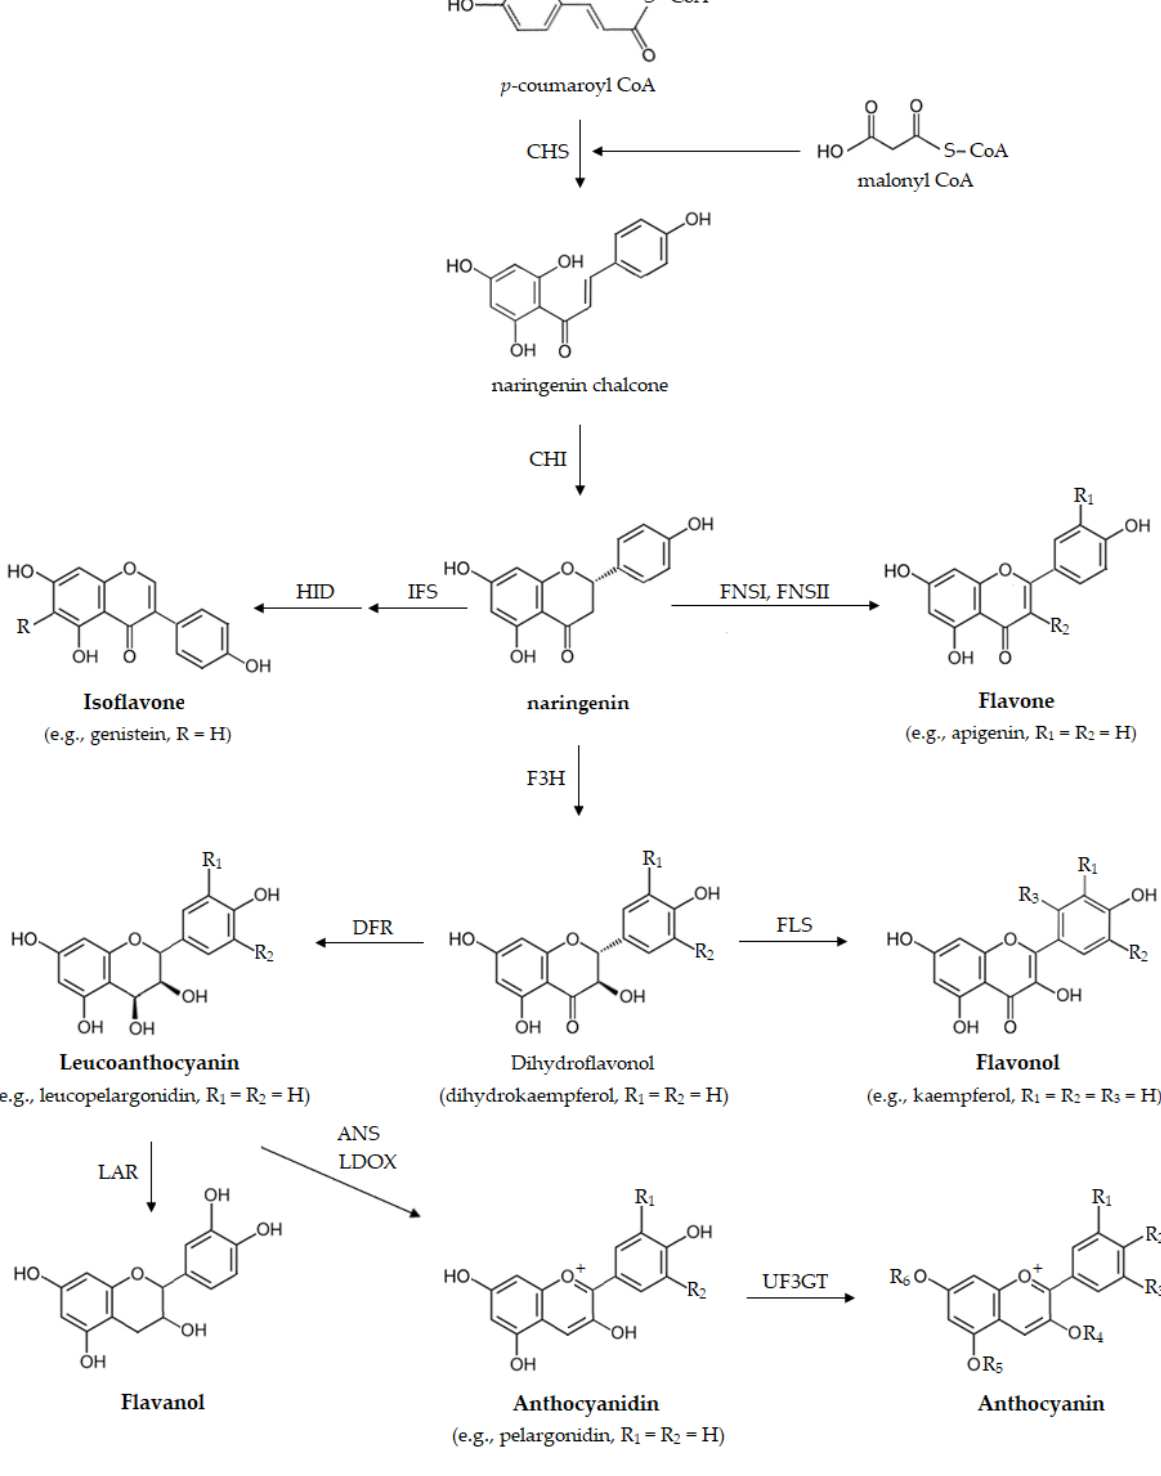
Figure 1. Biosynthetic pathway of flavonoids illustrated for naringenin and derivatives. ANS, anthocyanidin synthase; CHI, chalcone isomerase; CHR, chalcone reductase; CHS, chalcone synthase; DFR, dihydroflavonol 4-reductase; F3H, flavanone 3-hydroxylase; FLS, flavonol synthase; FNS, flavone synthase; HID, 2-hydroxyisoflavanone dehydratase; IFS, isoflavone synthase; LAR, leucoan- thocyanidin reductase; LDOX, leucoanthocyanidin dioxygenase; UF3GT, UDP-glucose flavonoid 3- O